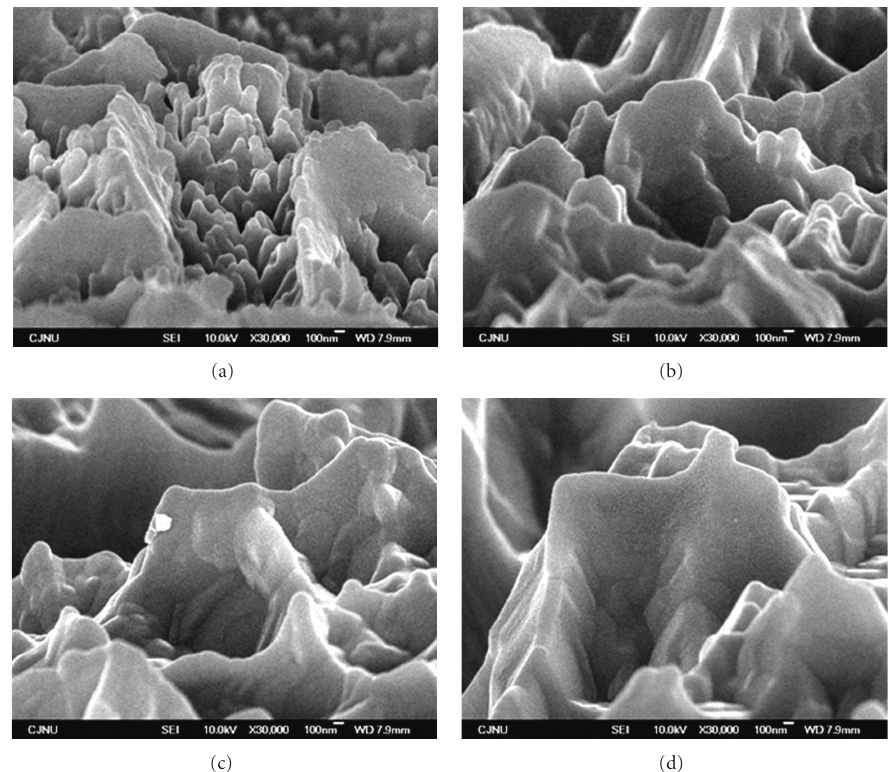
Figure 4: SEM images of RIE textured surface with various DRE times (30000x): (a) No DRE, (b) DRE 20 sec, (c) DRE 40sec, and (d) DRE 60sec.